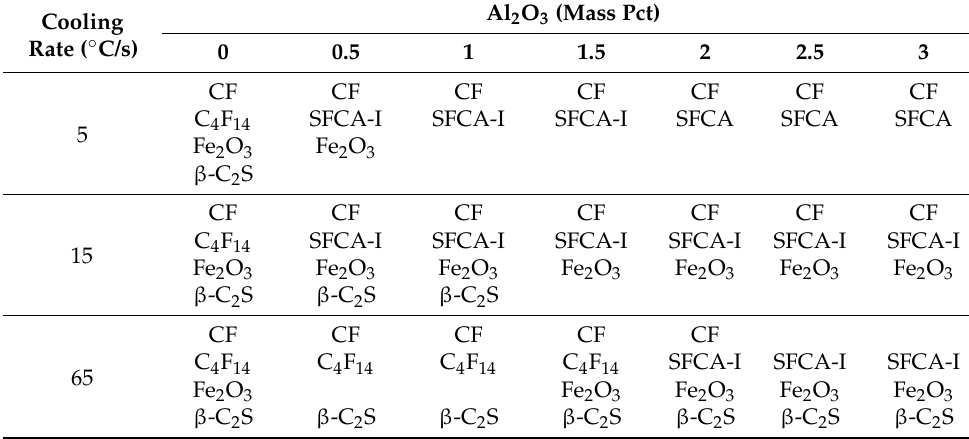
Figure 10. XRD patterns of samples with different Al 2 O 3 content cooled at 65 ◦ C/s. Table 4. The crystalline phase of the corresponding samples in Figures 8–10 Figure 8 Figure 9 Figure 10 .